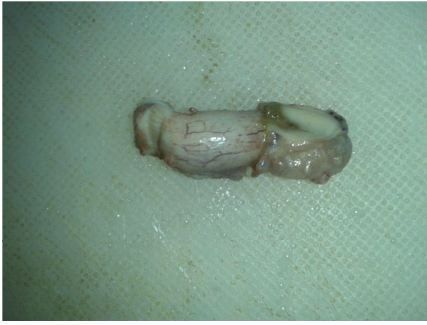
Figure 1: Gross specimen of appendix showing multiple tubercles in periappendiceal fat and surface.